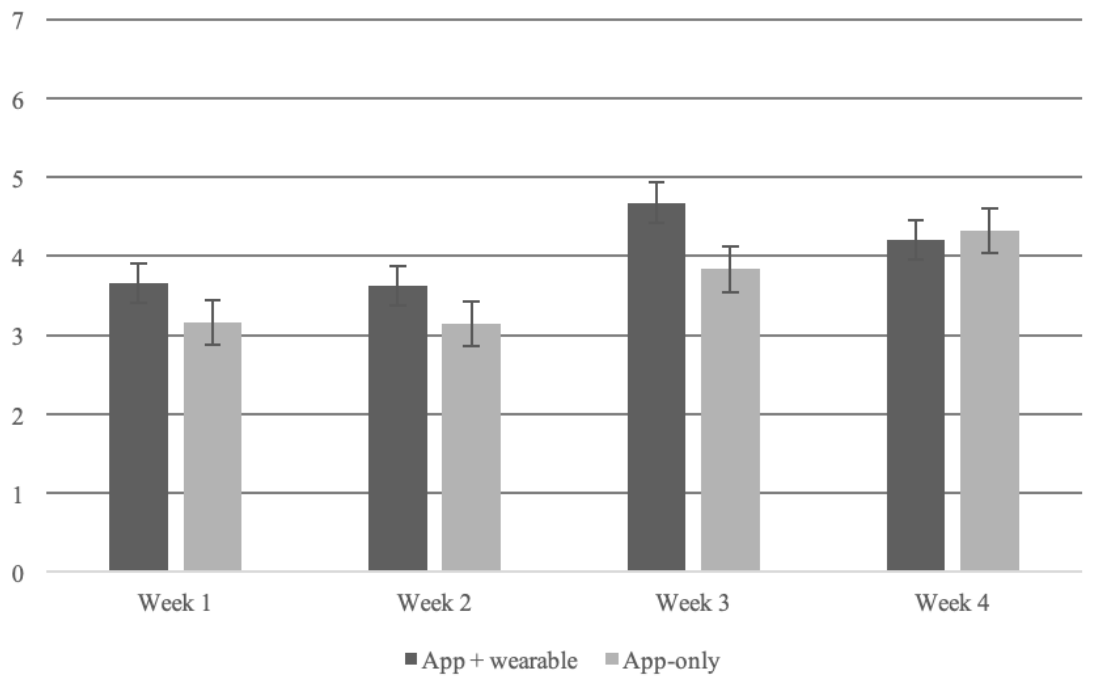
Figure 8. Patient response to clinician feedback